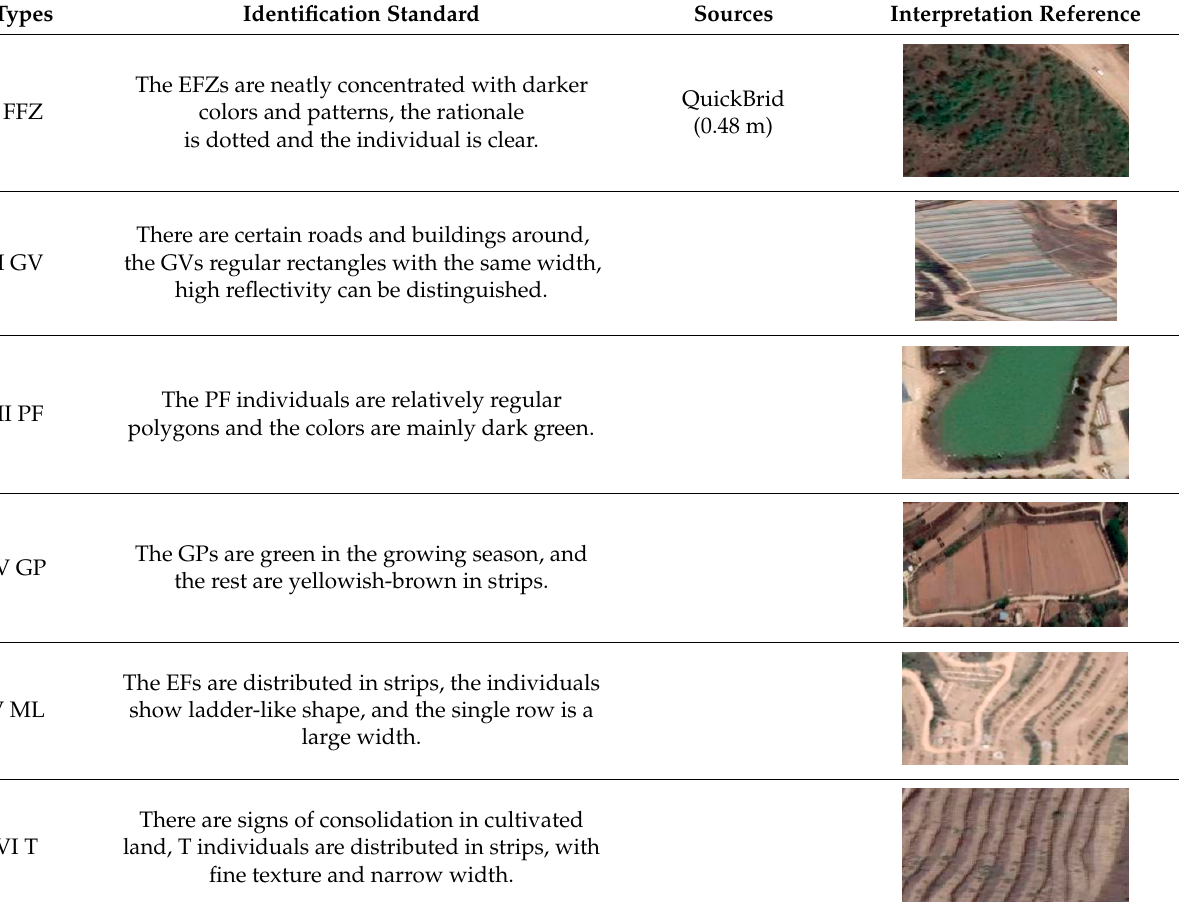
Table 2. The driving index of